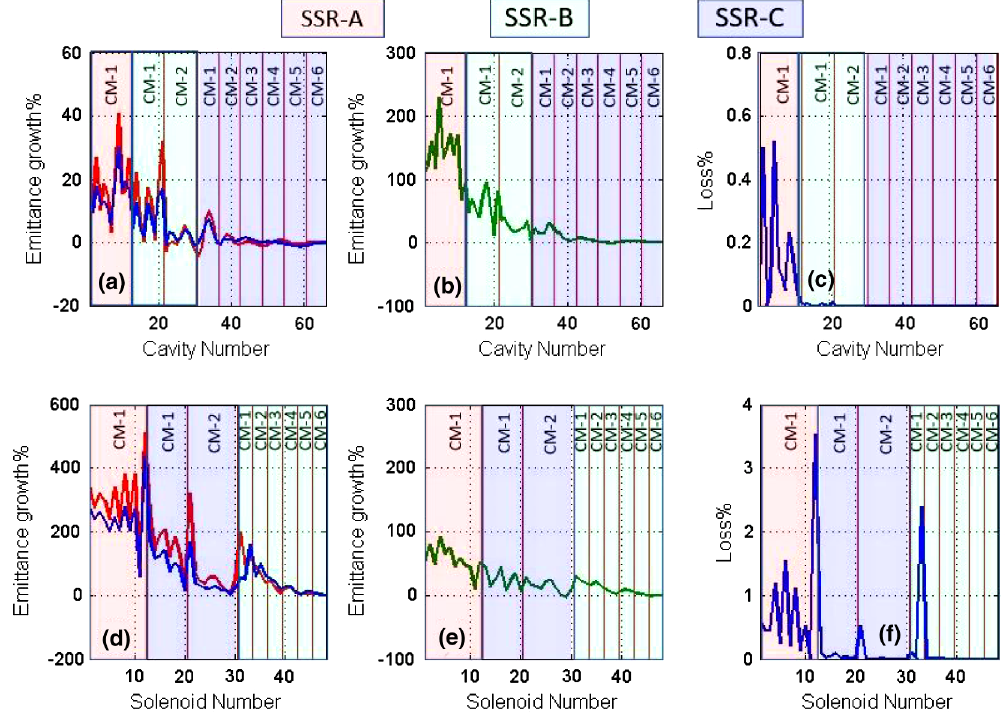
FIG. 42. Variation of (a) transverse emittance because of cavity failure, (b) longitudinal emittance because of cavity failure, (c) particle loss % because of cavity failure, (d) transverse emittance because of solenoid failure, (e) longitudinal emittance because of solenoid failure, and (f) particle loss % because of